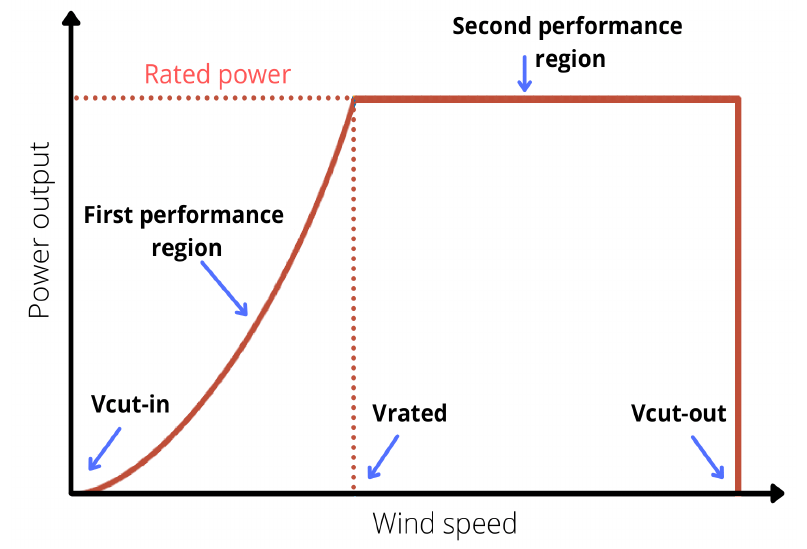
Figure 2. Variation of wind turbine generator power with wind speed.